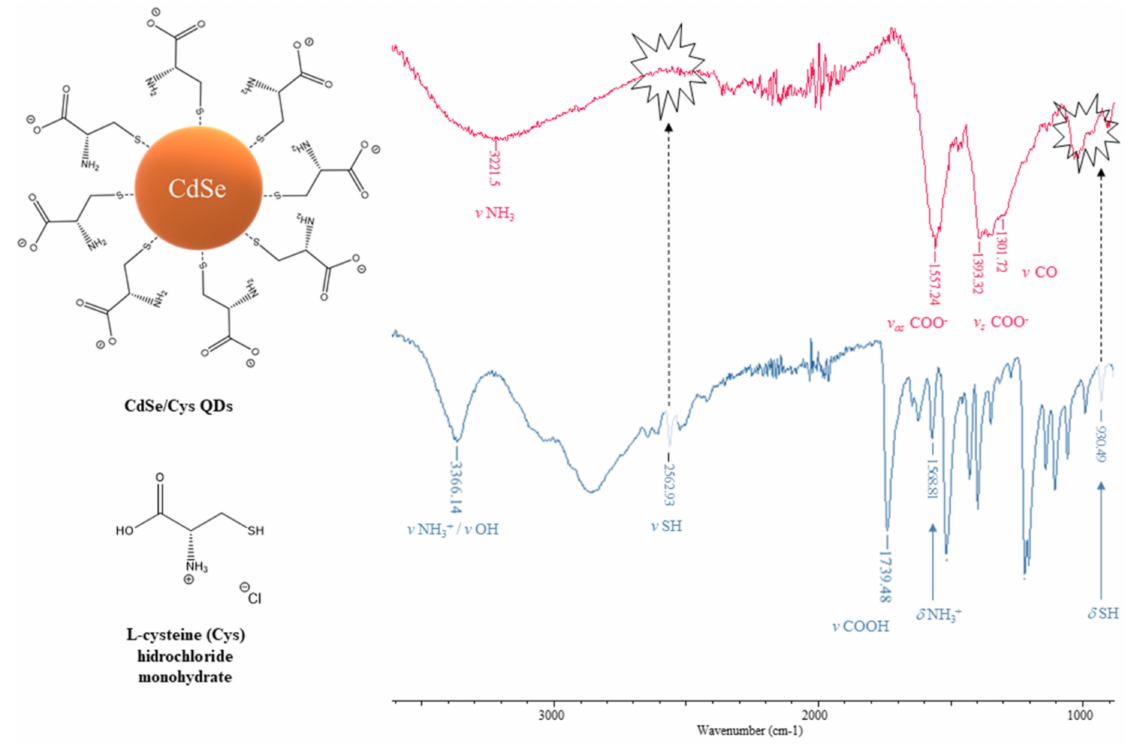
Figure 5. ATR–FTIR spectrum cysteine-capped CdSe QDs ( top ). The spectrum of L-cysteine ( bottom ) has been included for comparison